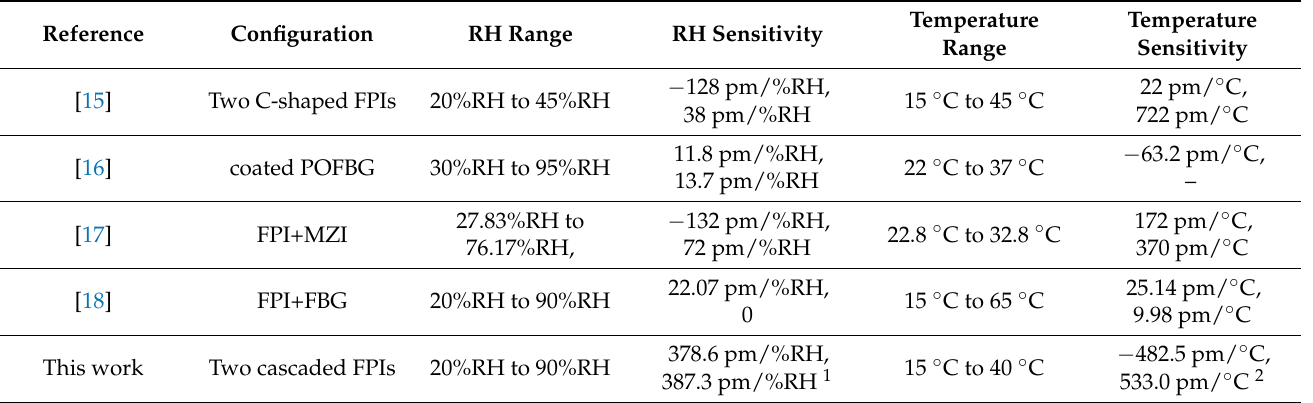
Table 1. Comparison with other similar